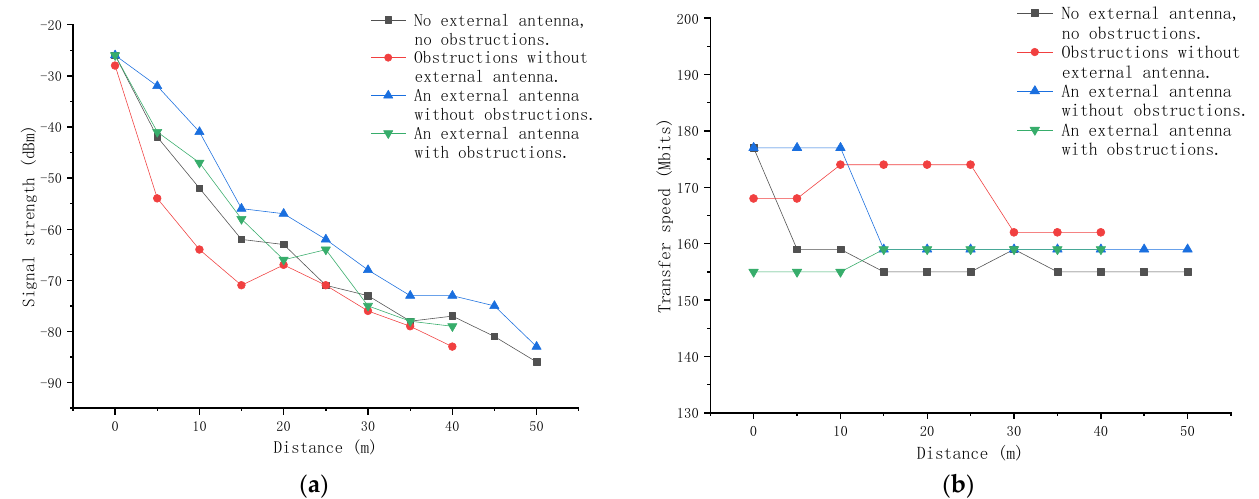
Figure 14. The test results of the environmental information sensing unit: ( a ) signal strength; ( b ) transmission rate.